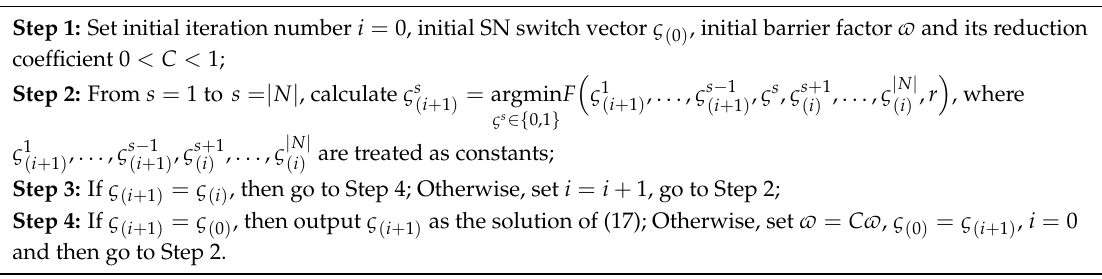
Algorithm 3. Coordinate descent